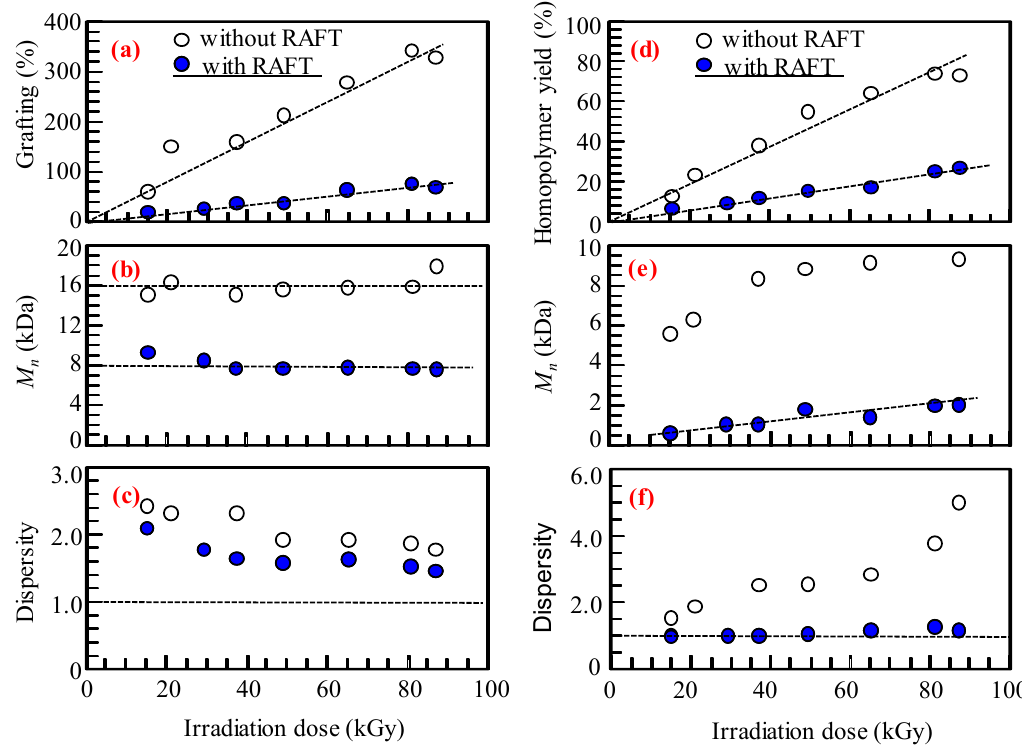
Figure 4. ( a ) Degree of grafting, ( b ) average molecular weight ( M n ), ( c ) dispersity of the extracted poly(CMS), and ( d ) homopolymer yield, ( e ) M n , ( f ) dispersity of the homopolymer in monomer solution as a function of the irradiation dose. Irradiation dose rate, 1.0 kGy/h; [RAFT]/[CMS], 0.014.